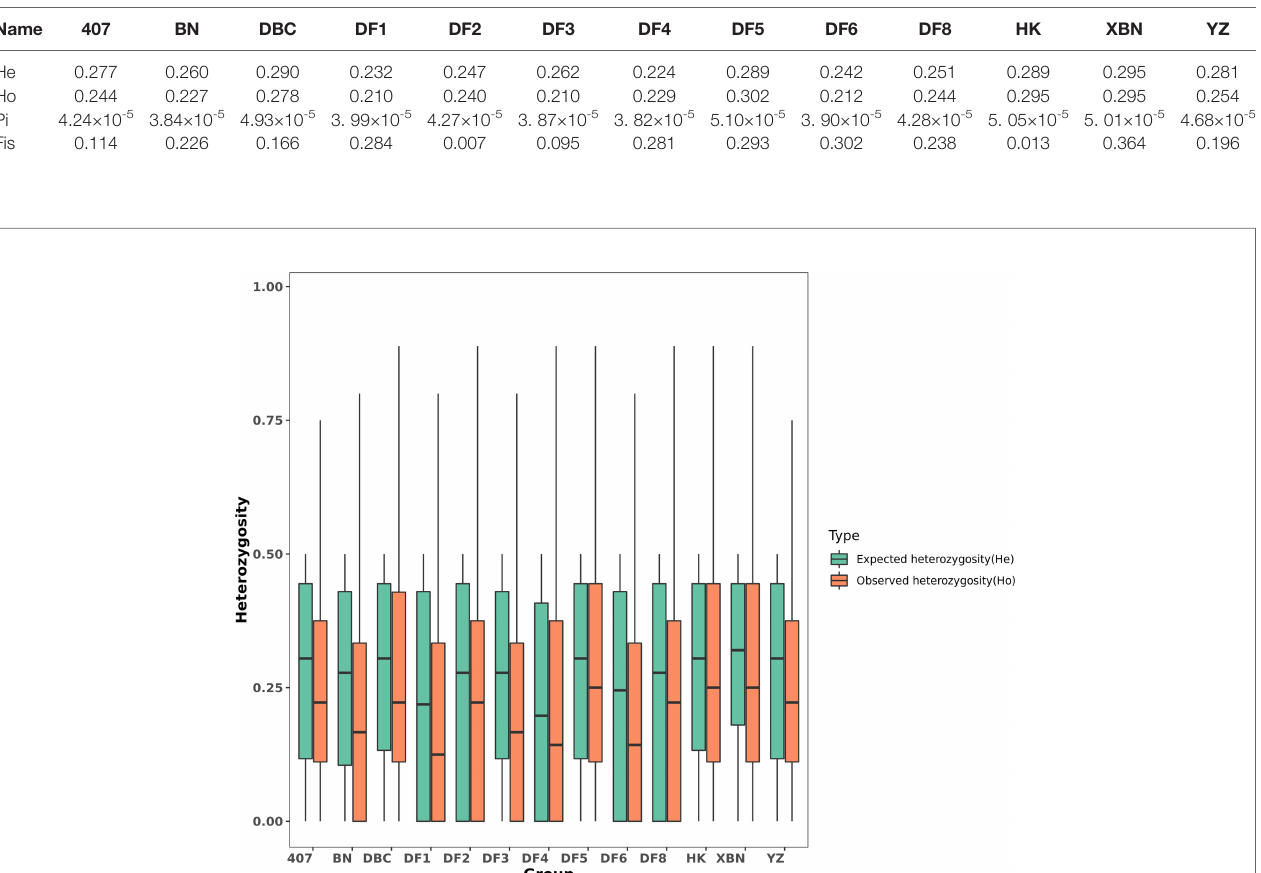
TABLE 2 | The PIC of SNP of 13